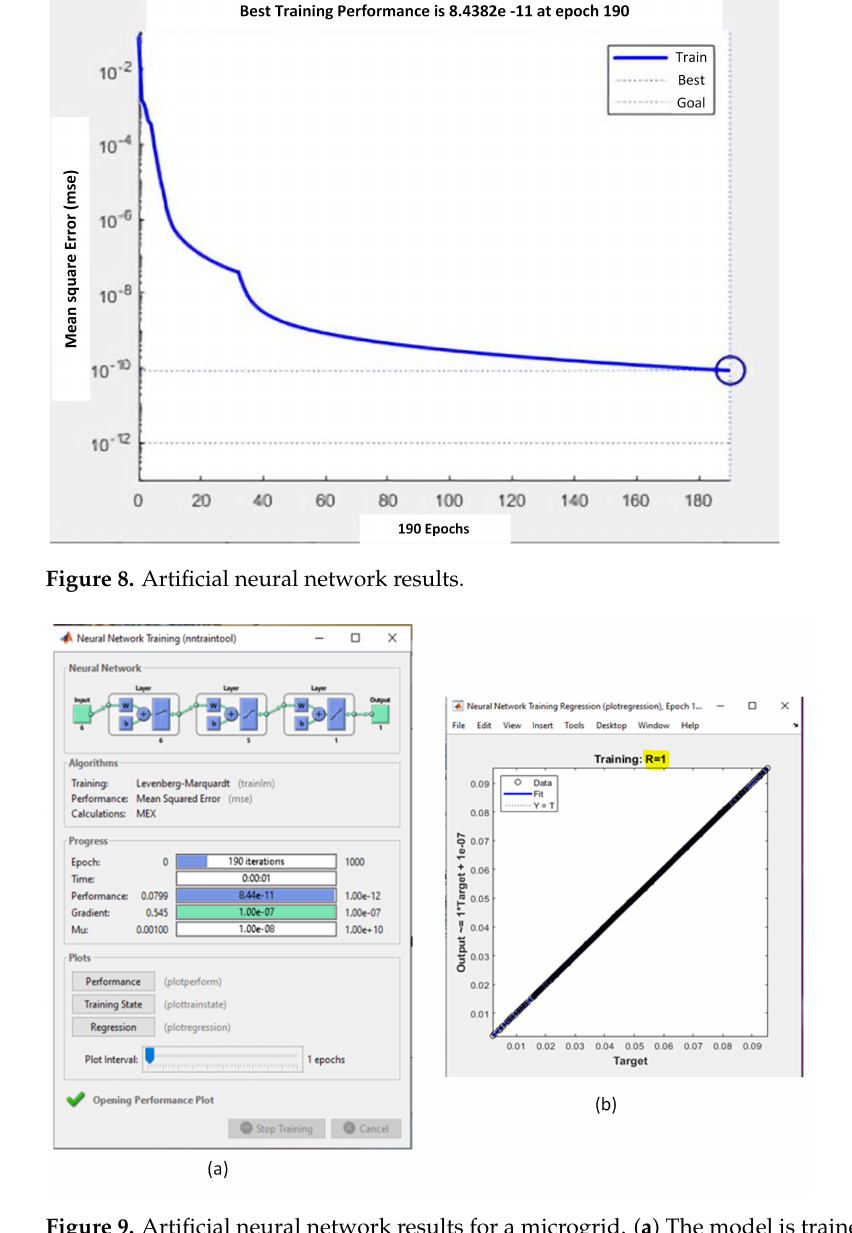
Figure 9. Artificial neural network results for a microgrid. ( a ) The model is trained for 1000 values using the Levenberg–Marquardt training method. ( b ) The output of the ANN after the model is fully